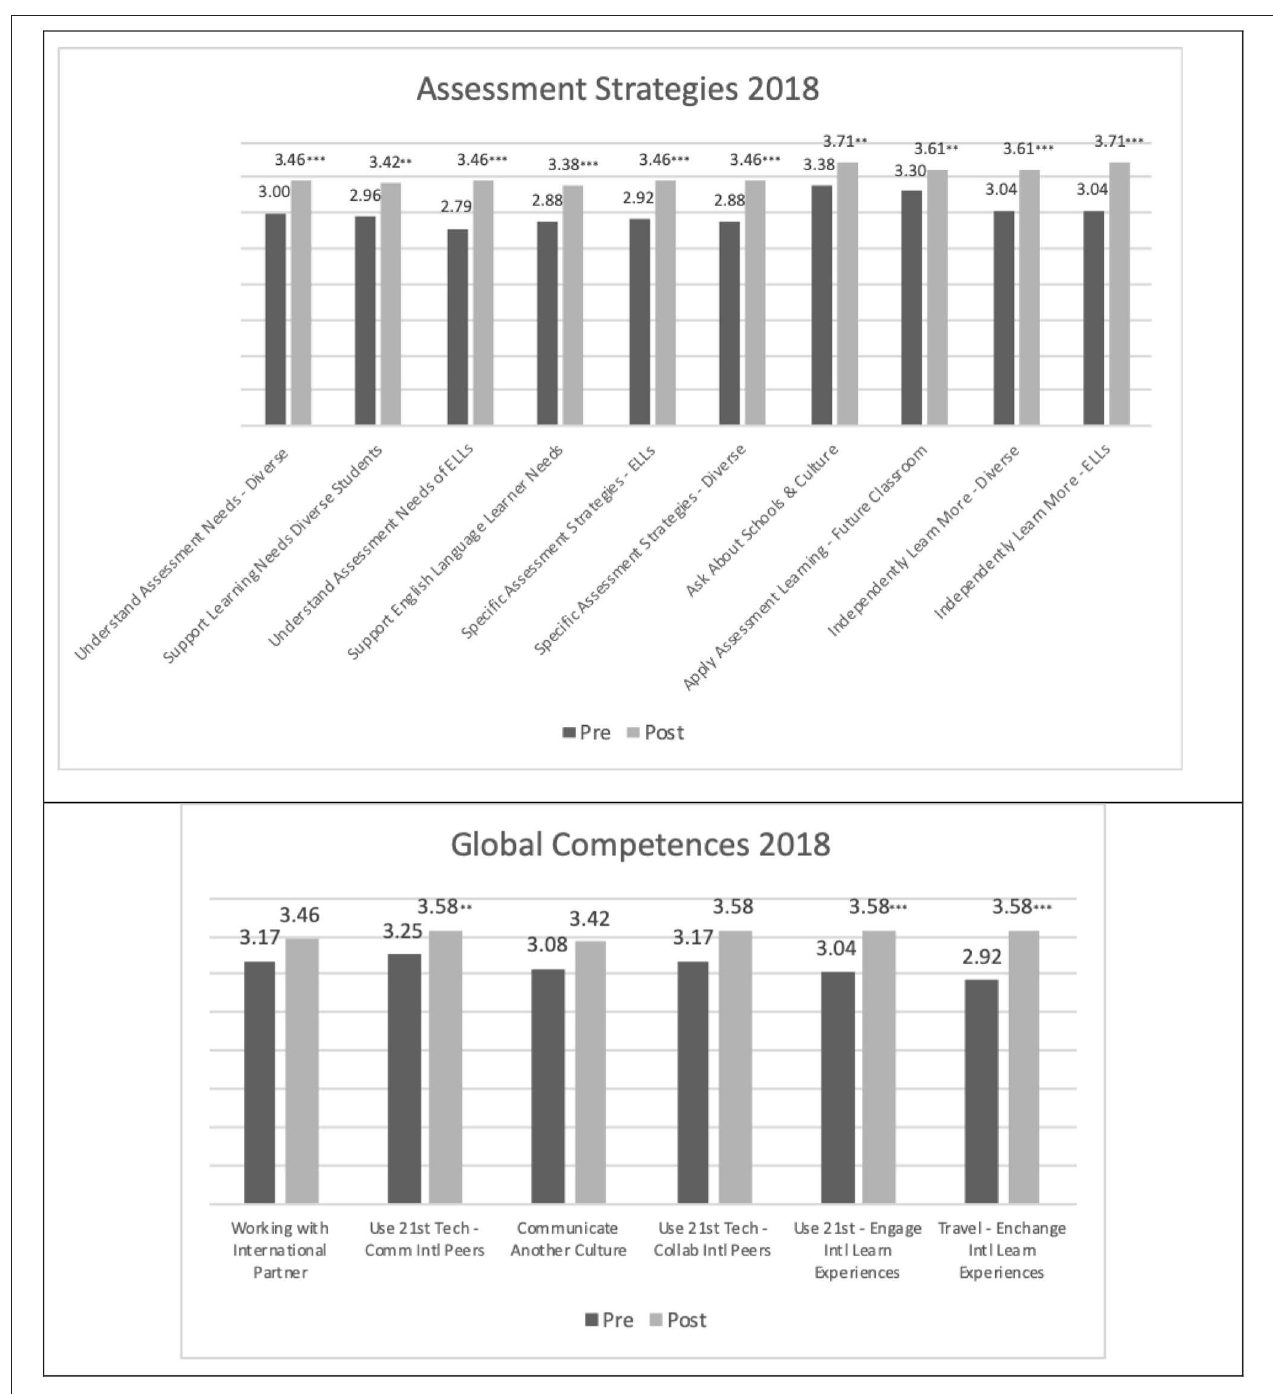
FIGURE 2 | American students’ pre to post-survey results (2018). ** p < 0.01; *** p < 0.001.